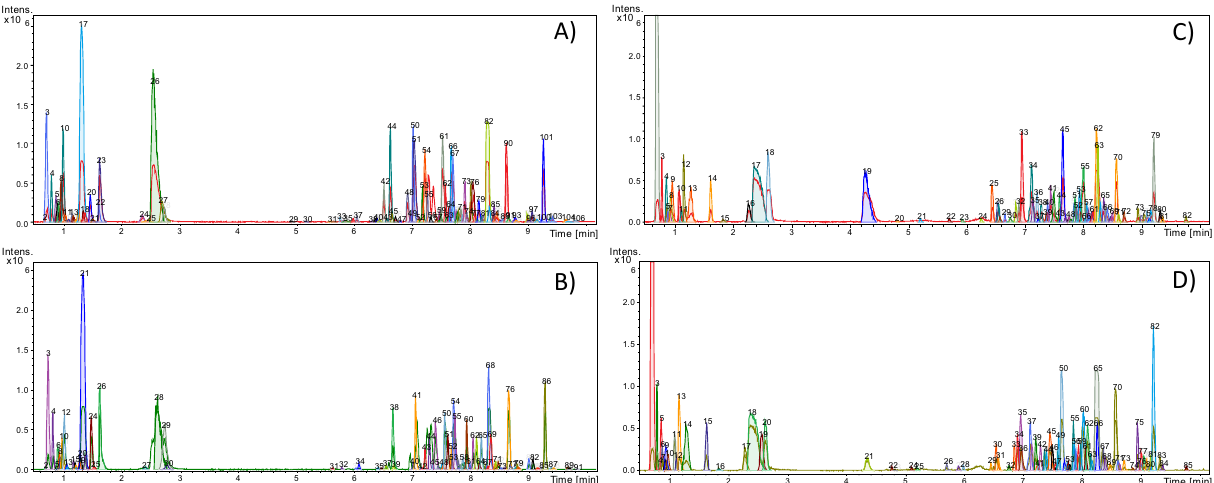
Figure 1. Total ion chromatogram (TIC) of representative samples after use of “dissect” algorithm. ( A ) Drought stress sample using UHPLC–ESI(−)–MS. ( B ) Control sample using UHPLC–ESI(−)–MS. ( C ) Drought stress sample using UHPLC–ESI(+)–MS. ( D ) Control sample using